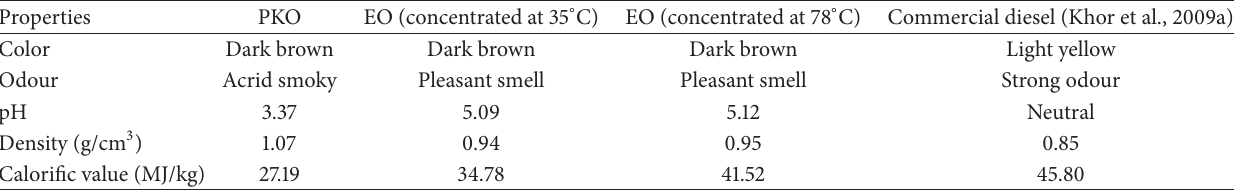
Table 3: Comparison of PKO and EO after